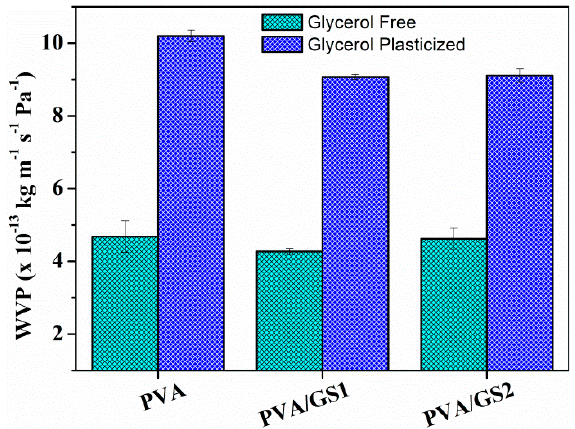
Figure 13. Water vapor permeability (WVP) for unplasticized and glycerol plasticized PVA and PVA/GS nanocomposites.